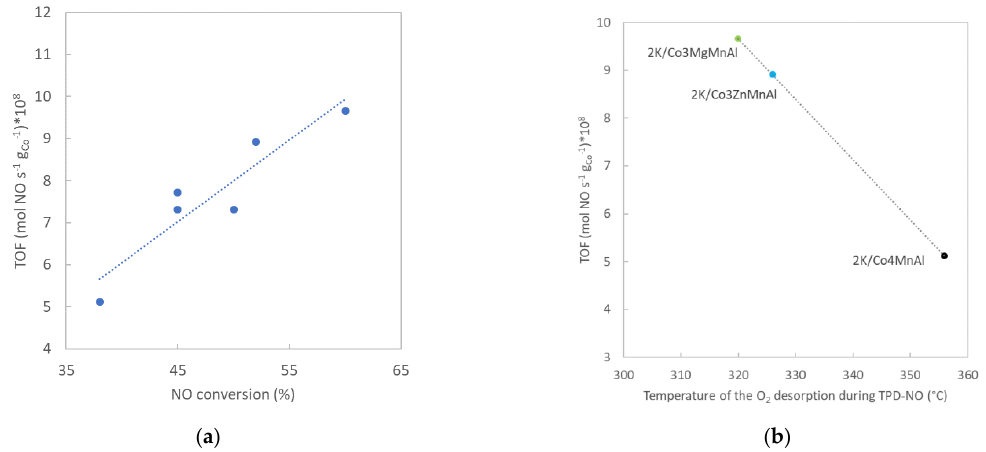
Figure 16. Dependence of TOF on: ( a ) NO conversion and ( b ) O 2 desorption.